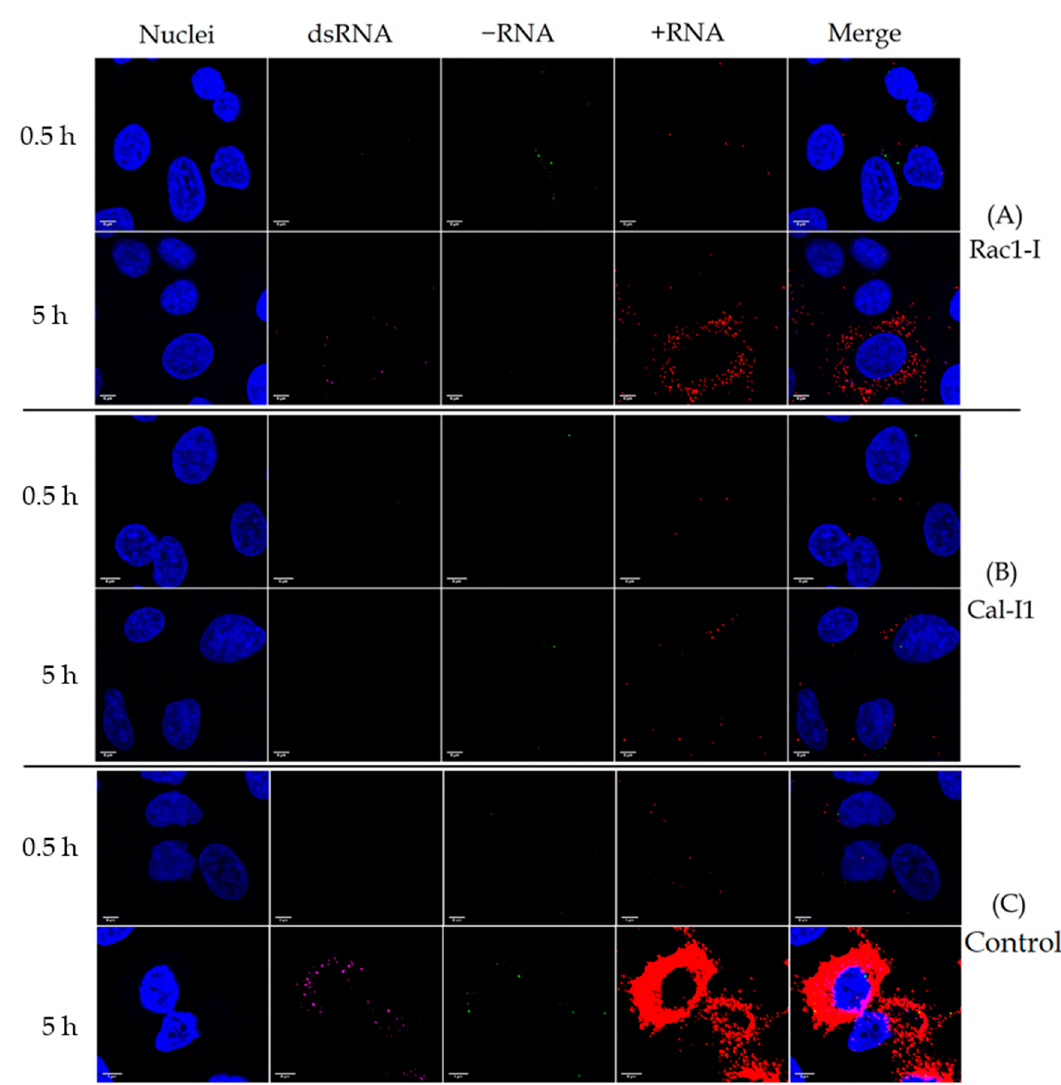
Figure 8. E ff ect of antiviral drugs Rac1-I and Cal-I1 and on the distribution on viral dsRNA, − RNA, and + RNA in CVA9-infected cells at timepoints of 0.5 h and 5 h p.i. Nuclei are shown in blue, dsRNA in magenta, − RNA in green, and + RNA in red. ( A ) Rac1-I inhibited the virus infection completely in most cells, but some cells exhibited input-virus levels of + RNA. ( B ) Cal-I1 inhibited the virus infection completely in almost all cells. ( C ) Control infection without the use of drugs showed the amount of viral dsRNA, − RNA, and + RNA in infected